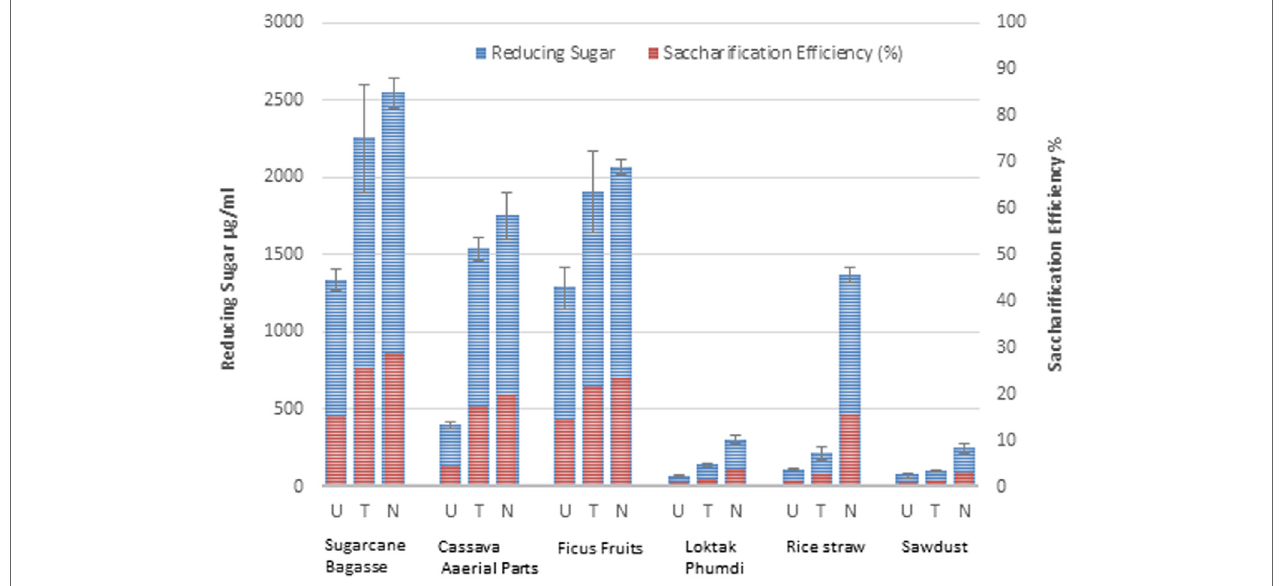
FigUre 5 | Reducing sugar yield (microgram per milliliter) and saccharification efficiency (%) of six different types of lignocellulosic biomass. U, untreated; T, hydrothermally treated; N, NaOH-treated are indicated. Data represented are the averages of the results from duplicated experiments (bar indicates ± SD).